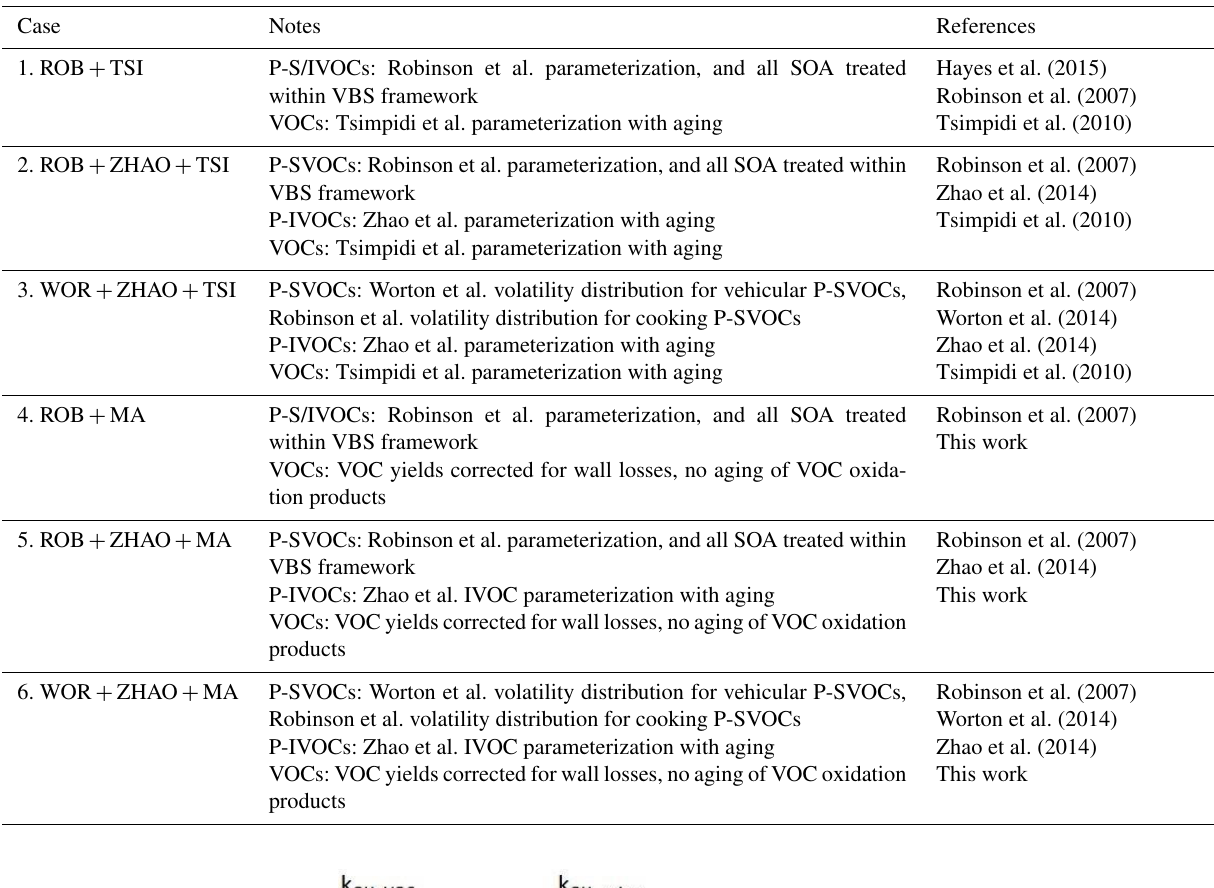
Table 1. Summary of the model cases used in this paper.